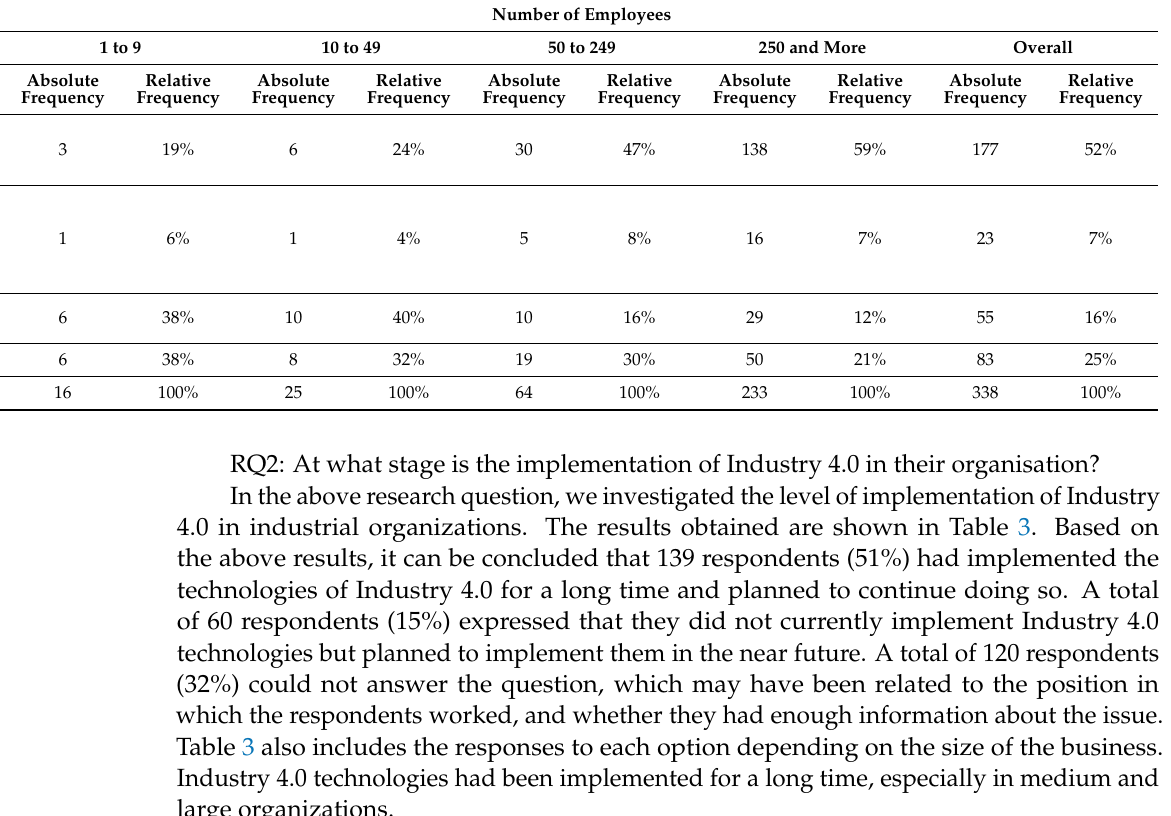
Table 2. The importance of the perception of Industry 4.0 in the organization. Number of